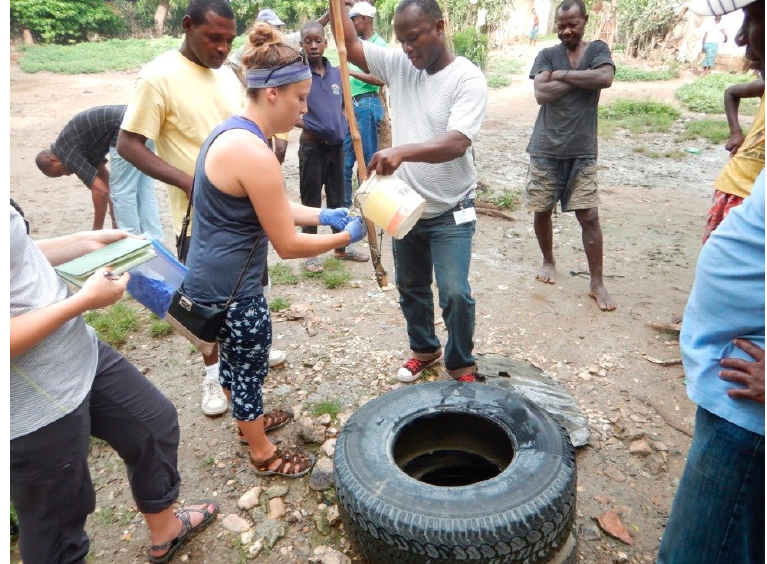
Figure 8. Flow chart depicting contamination pathways and treatment methods. Int. J. Environ. Res. Public Health 2018 , 15 , x